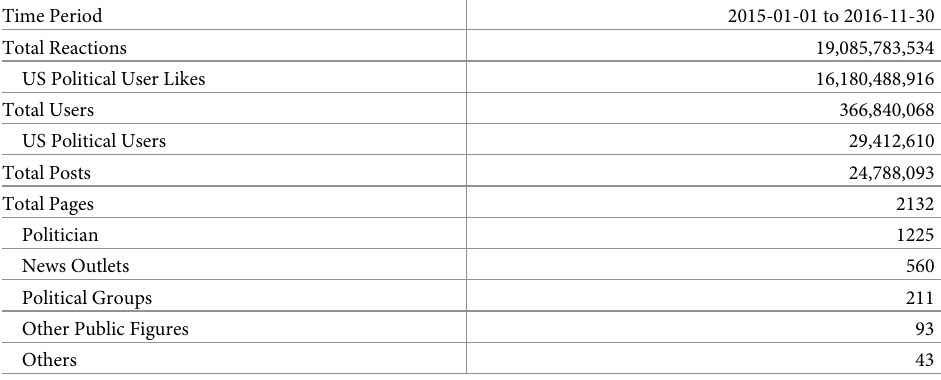
Table 1. Data summary (main